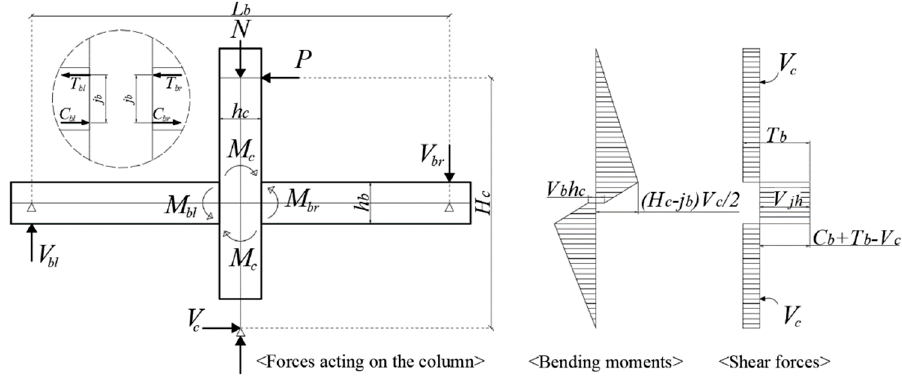
Figure A.1 . Internal forces and reaction forces acting on an interior beam–column connection under a lateral load .